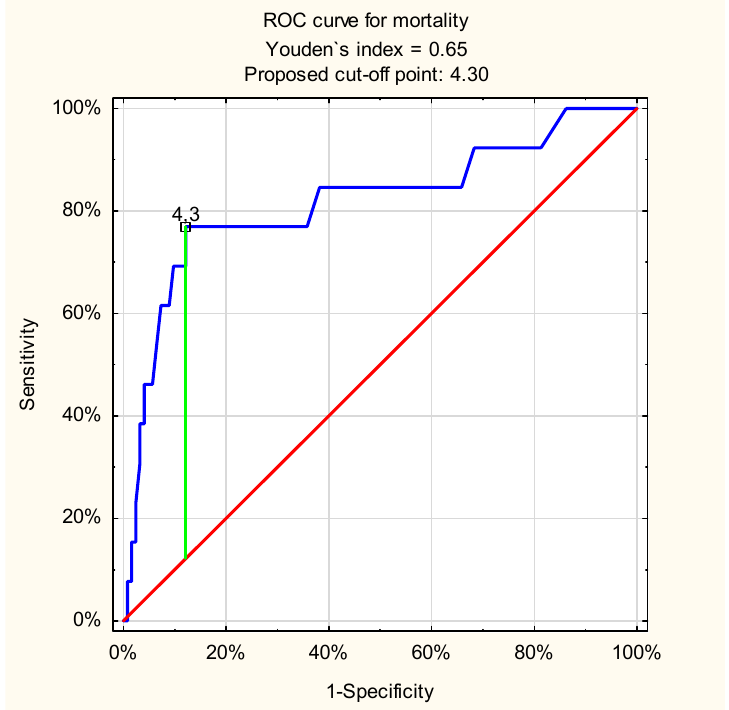
Figure 4. ROC curve for admission venous lactate level and in-hospital mortality in patients with bleeding peptic ulcers (proposed cut-off point = 4.3 mmol/L; sensitivity = 0.77; specificity = 0.88; accuracy = 0.87; AUC = 0.82 (95% CI: 0.67–0.96), p <